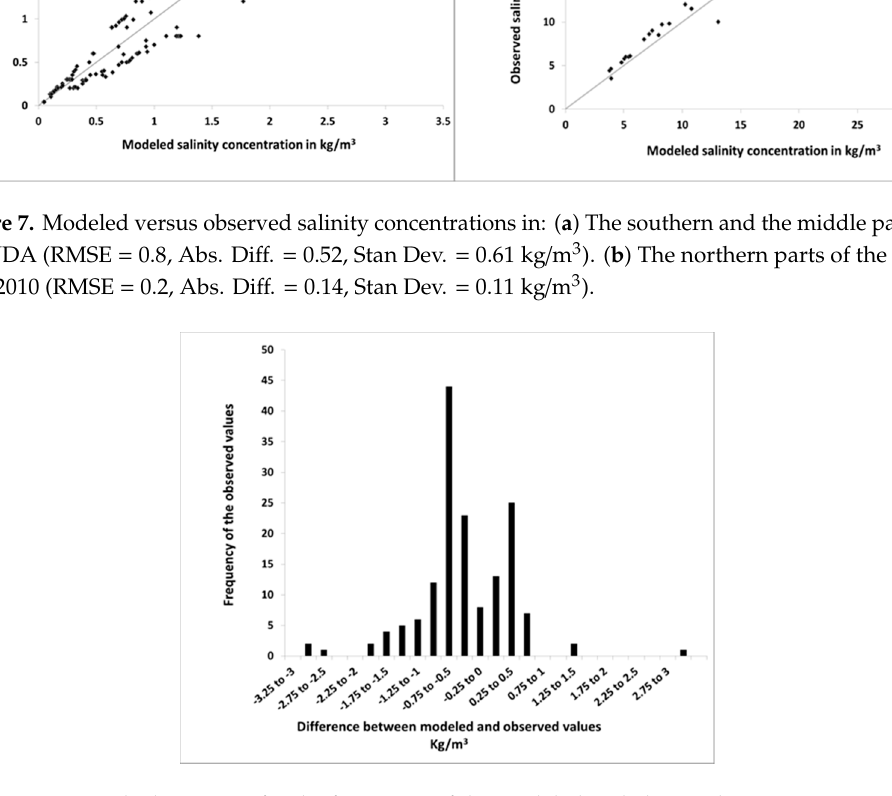
Figure 9. The frequency of relative error of modeled salinization concentrations with respect to observed concentrations. The total number of observations is 155.